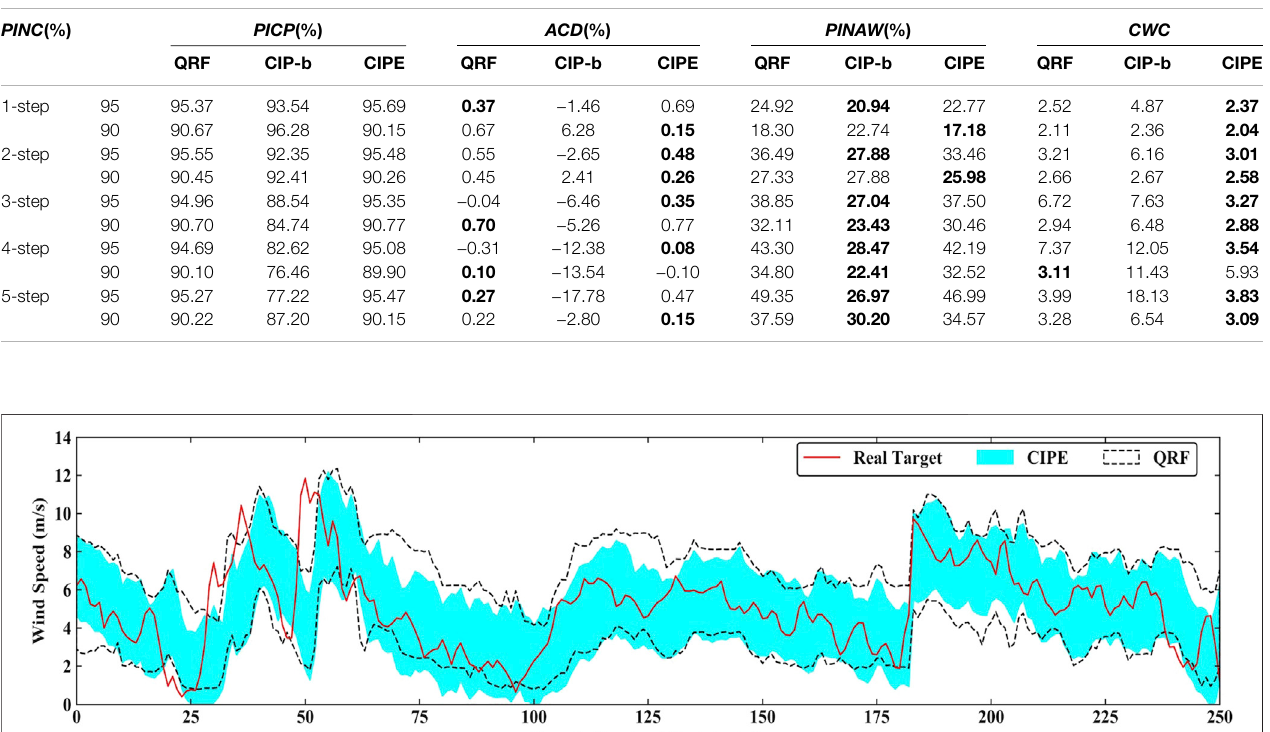
FIGURE 5 | Prediction result of CIPE and QRF under PINC = 90% in 4-step ahead prediction.